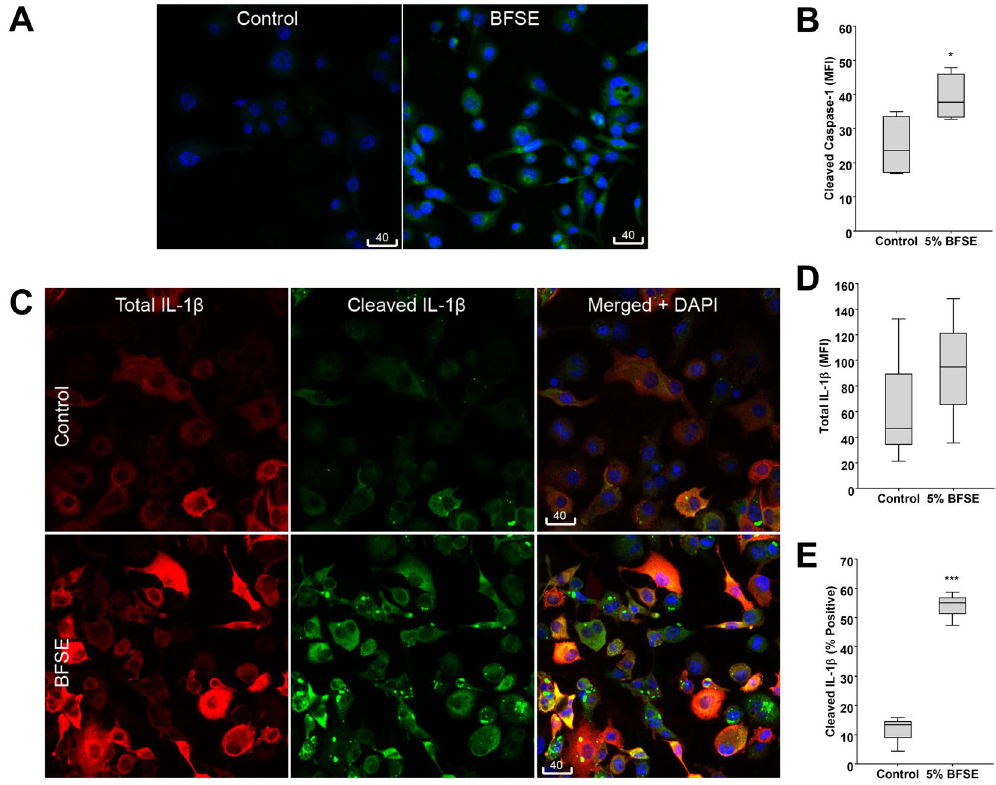
Figure 3. BFSE increases intracellular pro-inflammatory mediators. THP-1 macrophage cells were exposure to air control or 5% BFSE for 24 h. Active Caspase-1 ( A ) and; total IL-1 β and active IL-1 β ( C) were detected by immunofluorescence. Confocal images were quantitatively measured for MFI of active Capase-1 ( B ) and total IL-1 β ( D ), or the percentage of cells containing bright particulate active IL-1 β ( E ). (n = 4) * p < 0.05 *** p <